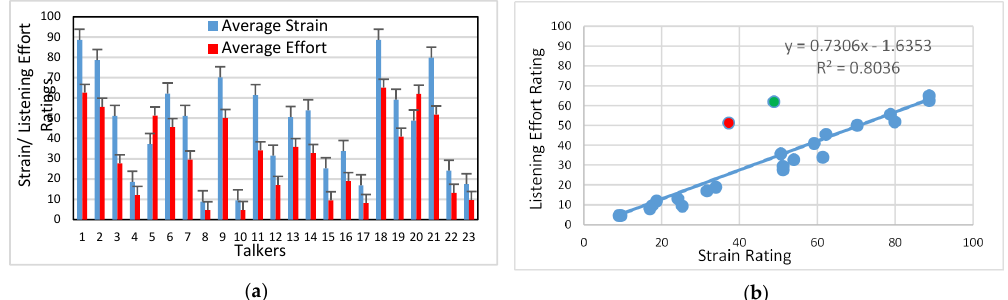
Figure 2. ( a ) Strain and listening effort ratings for each talker, averaged across all listeners and the test-retest sessions. Error bars indicate the standard error of the mean. ( b ) Scatter plot of the strain and listening effort rating data (averaged across listeners), along with the linear regression fit. The red and green color dots highlight data from talkers where the listening effort ratings were greater than the strain ratings.